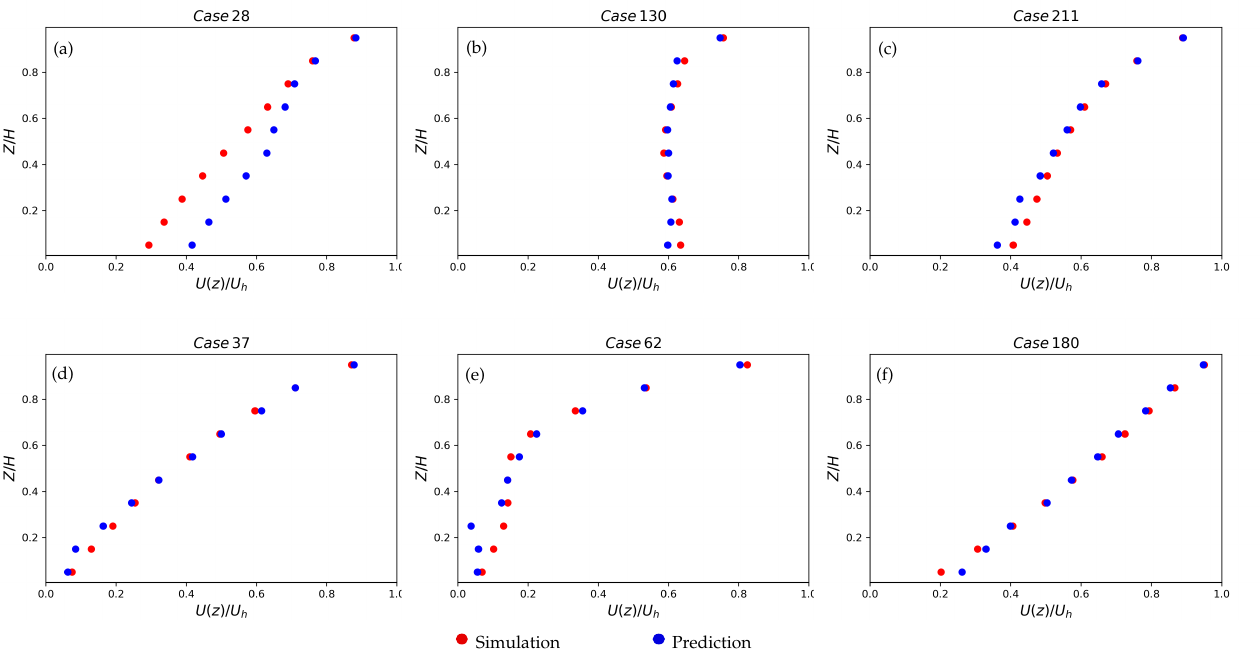
Figure 15. Velocity discrete points’ prediction: simulation data vs. ANN for unstable cases ( a – c ) and stable cases ( d – f ).